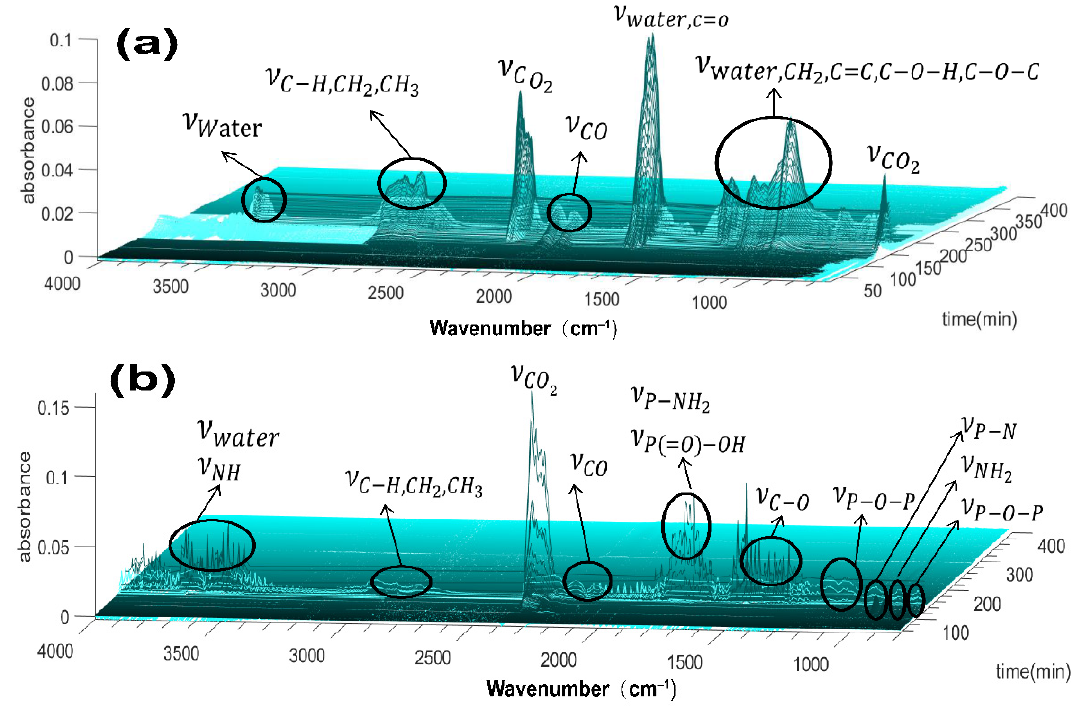
Figure 8. Three ‐ dimensional TG ‐ FTIR spectra of the control sample ( a ) and BDA ‐ 90 ‐ treated sam ‐ Figure 8. Three-dimensional TG-FTIR spectra of the control sample ( a ) and BDA-90-treated samples ples ( b ) (3 curing times, 50 LCs). ( b ) (3 curing times, 50